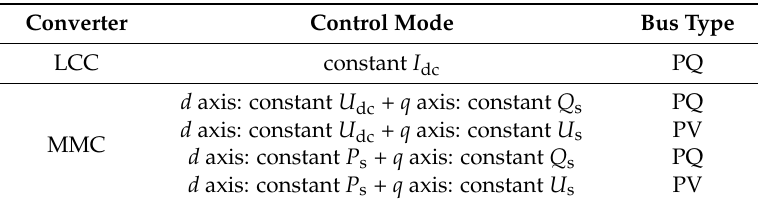
Table 2. Converter Bus